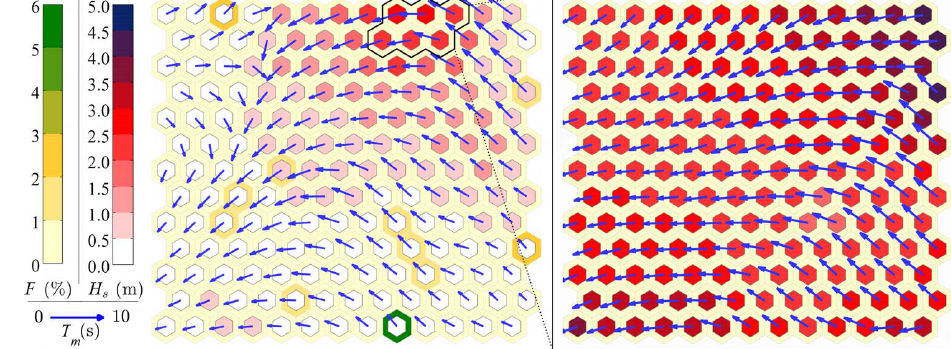
Figure 10. TSOM output map with threshold H ∗ s = 2 . 12m (97th percentile of H s ). H s : inner hexagons’ color, T m : vectors’ length, θ m : vectors’ direction, F : outer hexagons’ color. Wave climate after a single-step SOM (left panel) and TSOM extreme wave climate (i.e., over the threshold, right panel and cells within black solid line in the left panel). For the right panel map, mean quantization error: 0.04; topographic error: 6%.